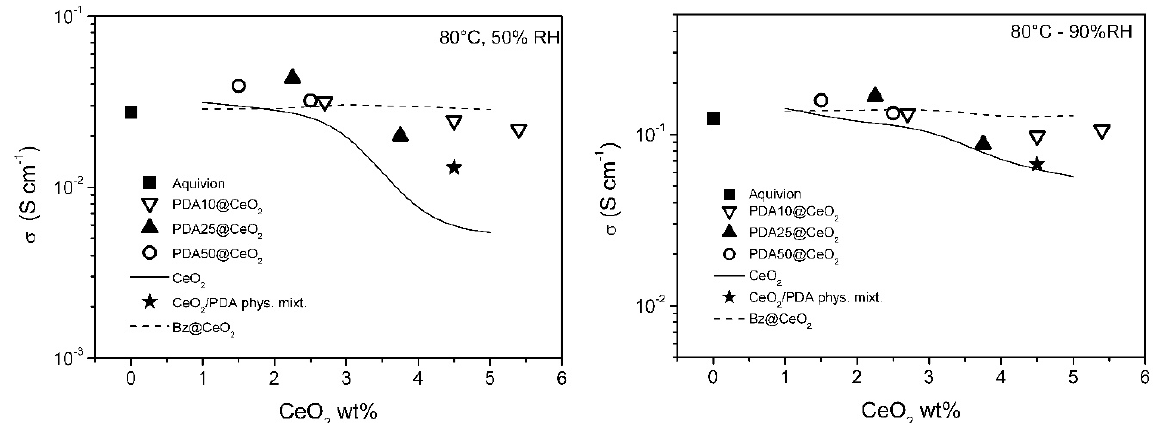
Figure 8. Conductivity as a function of CeO 2 loading, at 80 °C, for composite Aquivion membranes filled with PDAx@CeO 2 (x = 10, 25 and 50), as well as with the physical mixture PDA/CeO 2 (see text). The conductivity of composite Aquivion membranes containing bare CeO 2 and Bz@CeO 2 (redrawn from ref. [16]) is reported for comparison.